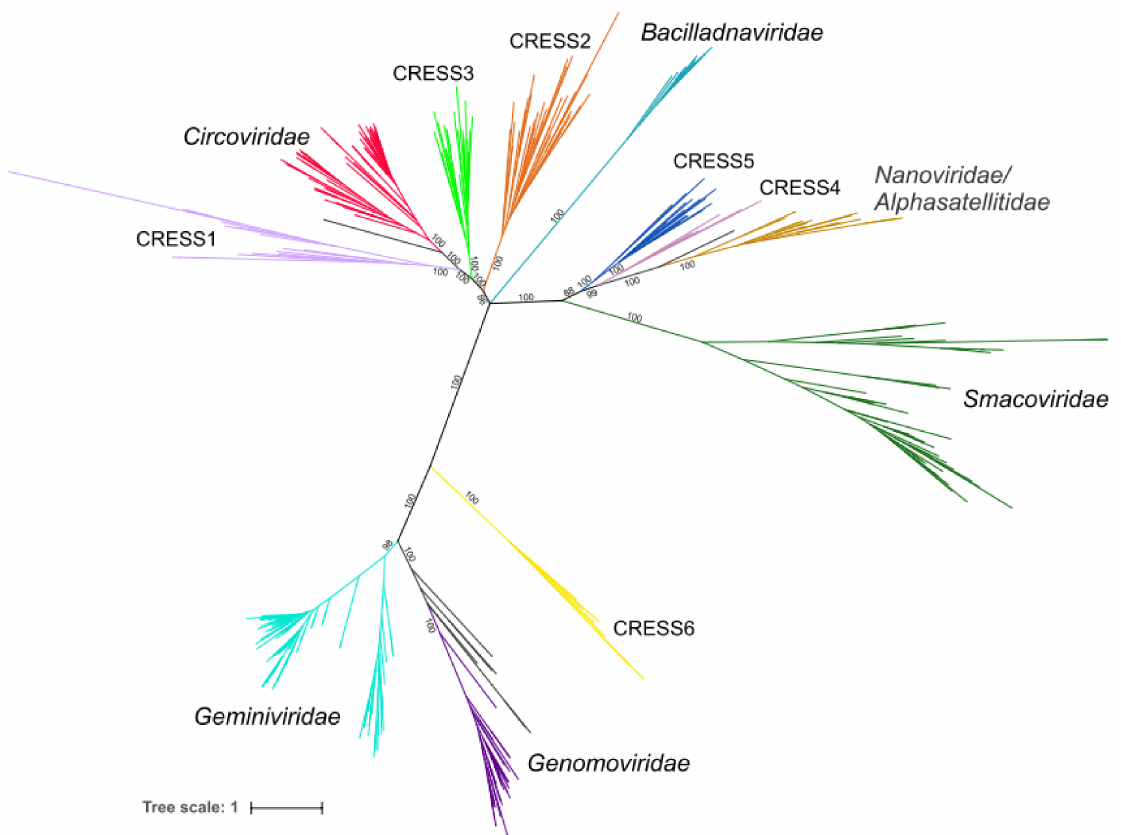
Figure 3. Phylogenetic tree of CRESS viruses generated after removing possible recombinant proteins. The tree is based on full-length Rep amino acid sequences. Clades belonging to the same group have the same colors as in Figure 1. Edges having support lower than 70% were contracted. The phylogeny was inferred using PhyML [32] with the rtREV+G+F (rtREV amino acid model; G, gamma shape parameter: fixed; F, equilibrium frequencies: empirical) substitution model using the alignment containing 412